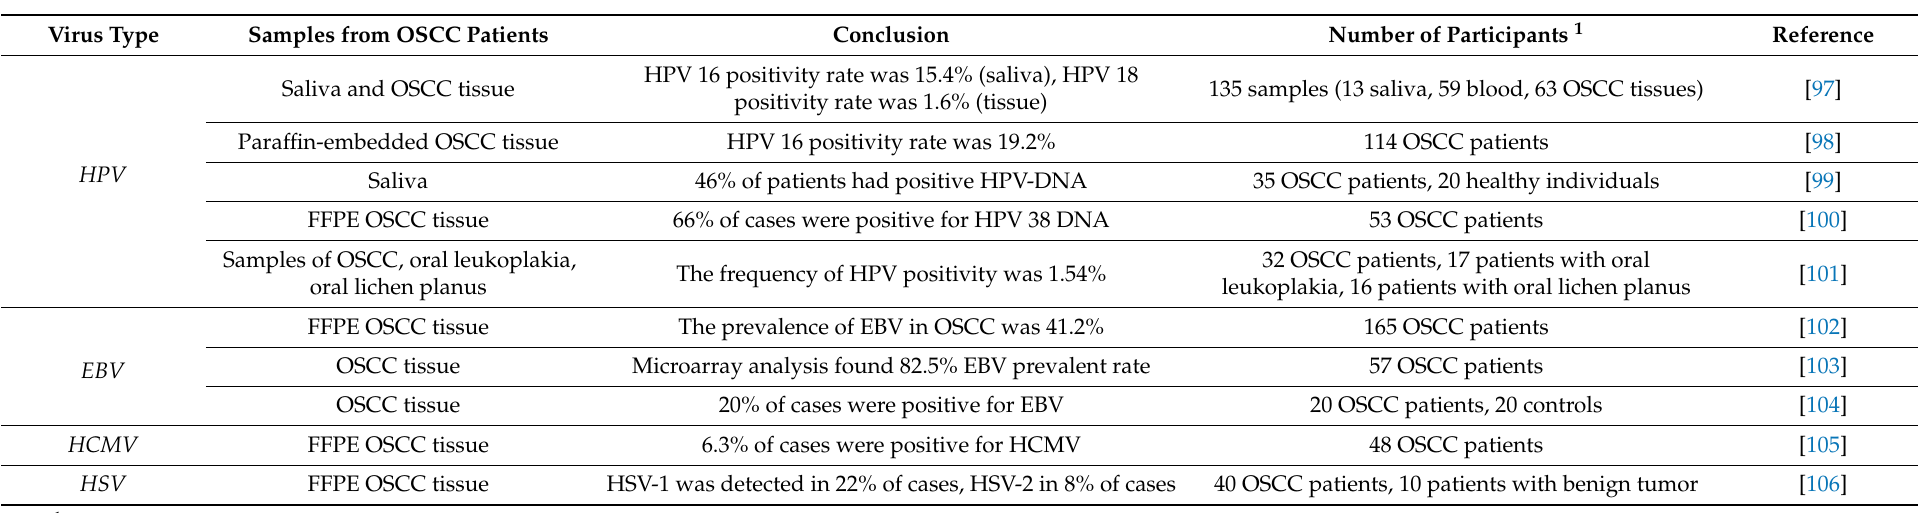
Table 3. An overview of viruses detected in samples from patients with oral cancer. All specimens were